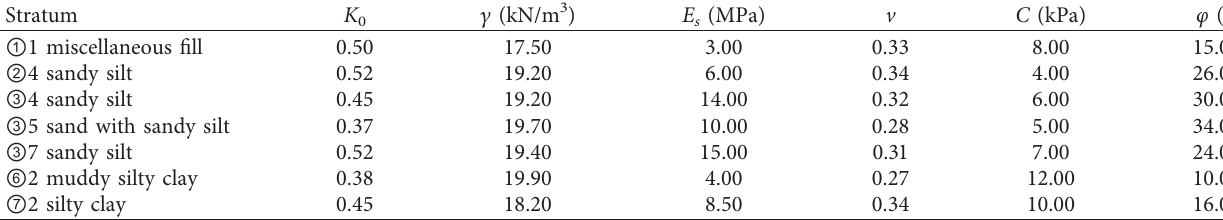
Table 2: Stratum physical parameters.